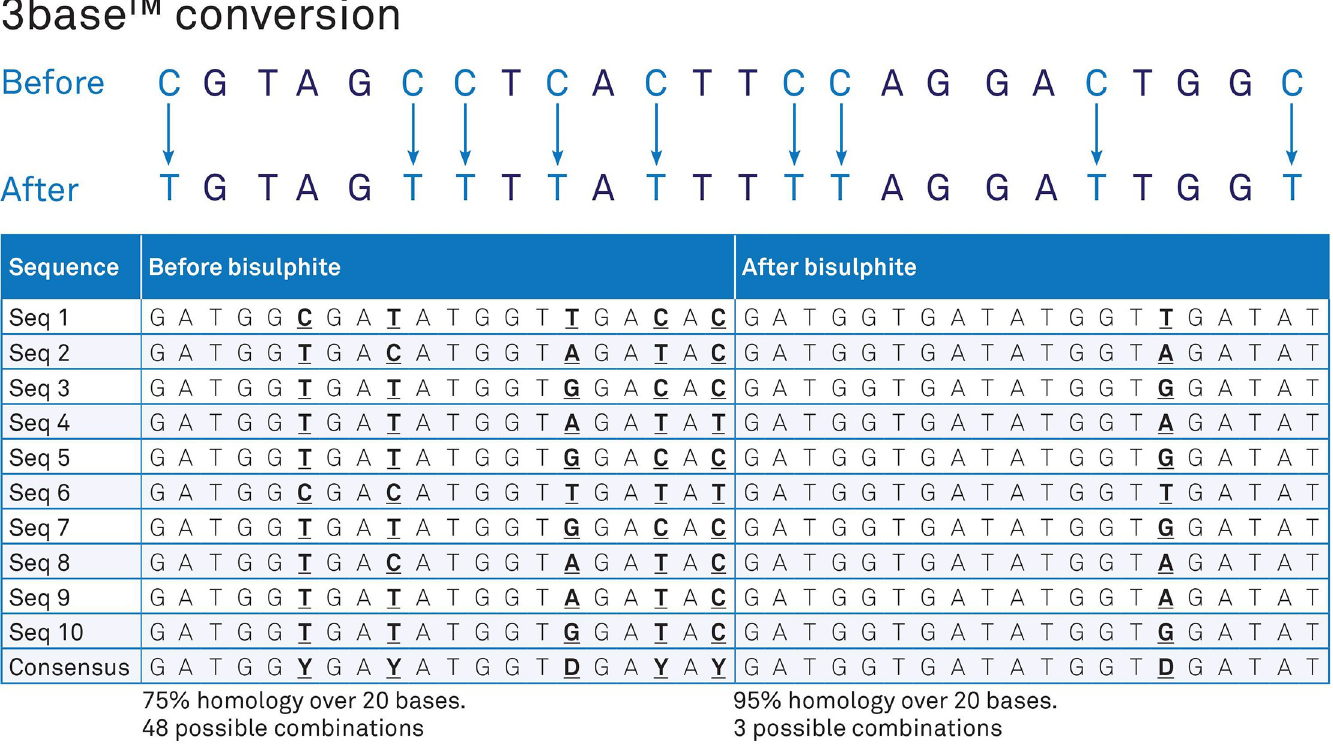
Fig 1. Example of the 3base mechanism. The example sequences below show the increase in homology from 75% (“Before”) to 95% (“After”) via the 3base conversion where all C bases are detected as T bases.